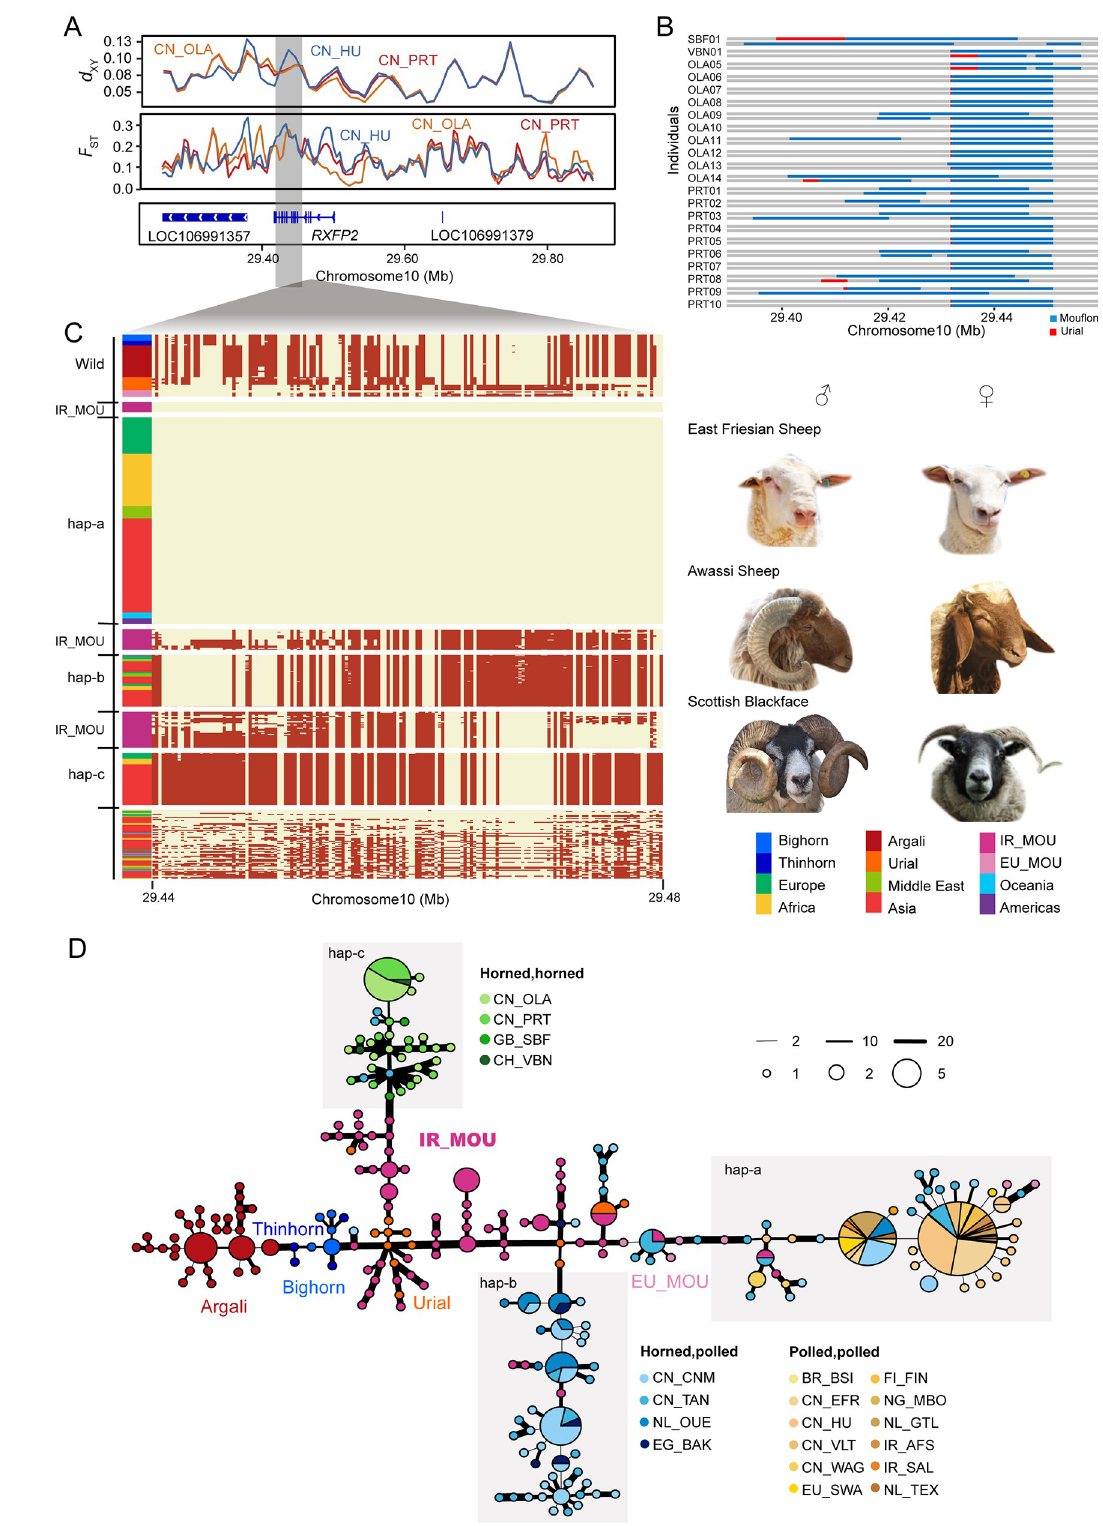
Fig 4. Identification and haplotype resolution of introgressed fragment at the RXFP2 locus. (A) Distributions of mean pairwise sequence divergence ( d XY ) values and pairwise fixation index ( F ST ) values calculated by Iranian mouflon and domestic